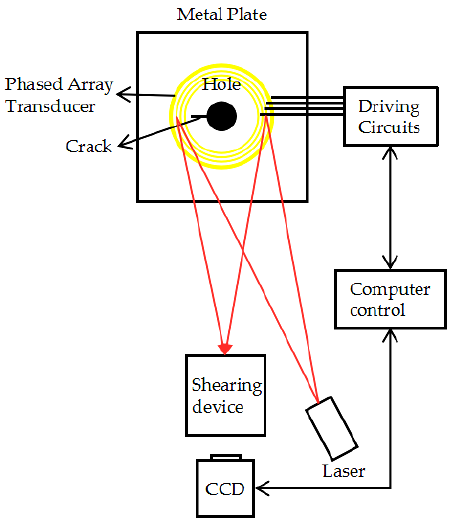
Figure 13. Experimental setup of directed acoustic shearography.